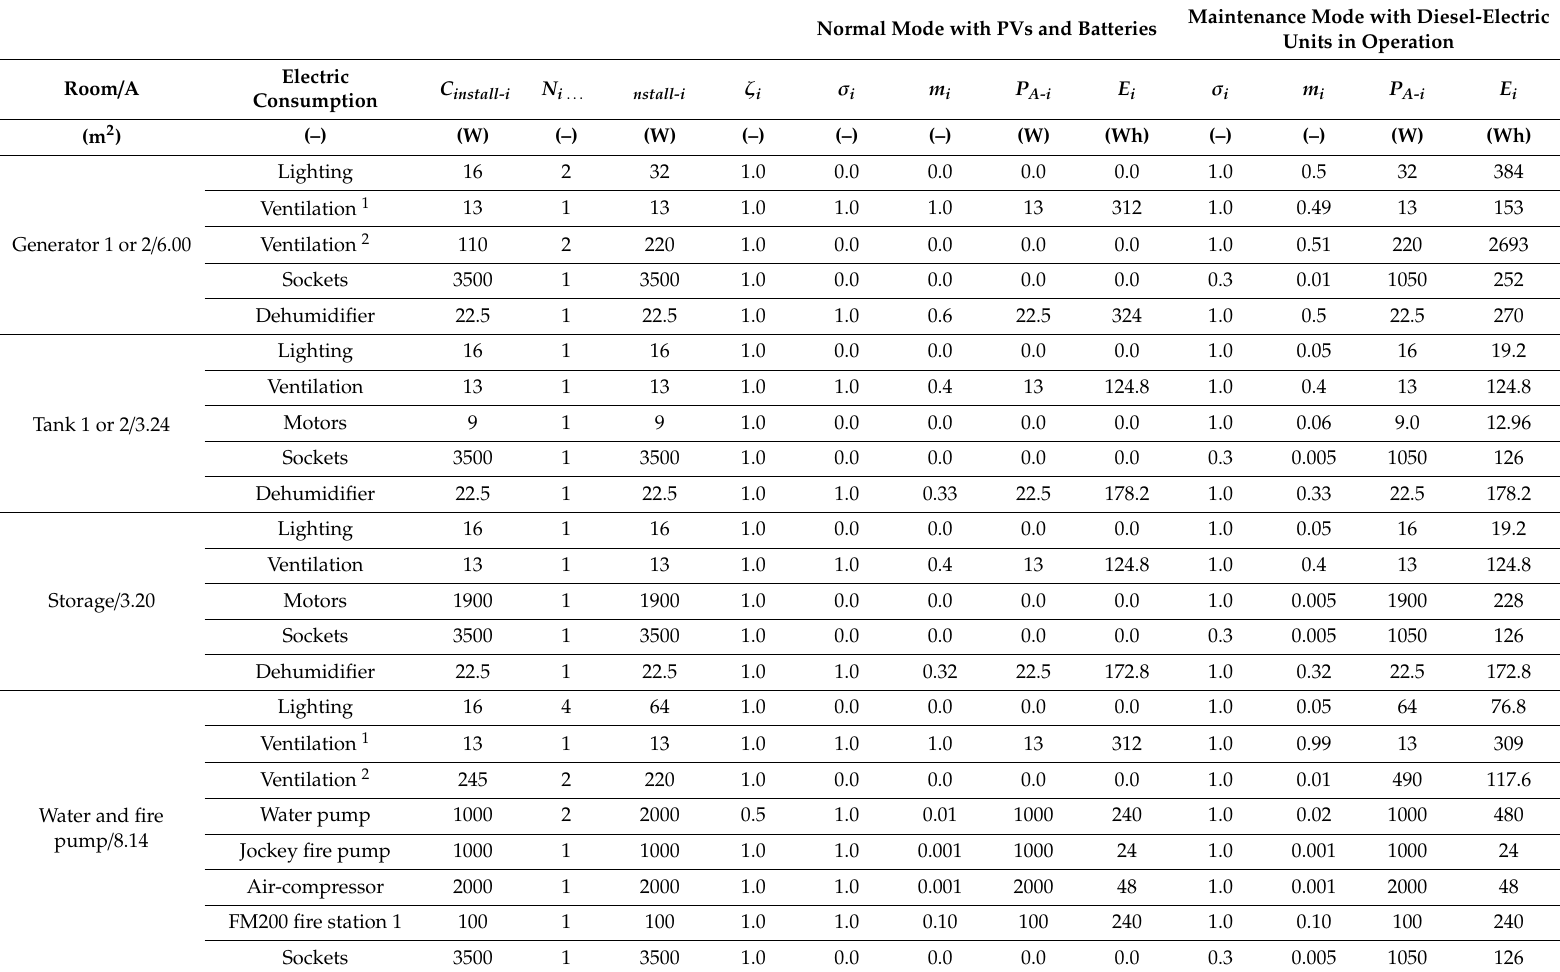
Table 1. Daily peak power and energy consumption for the electrode station in Stachtoroi Island,